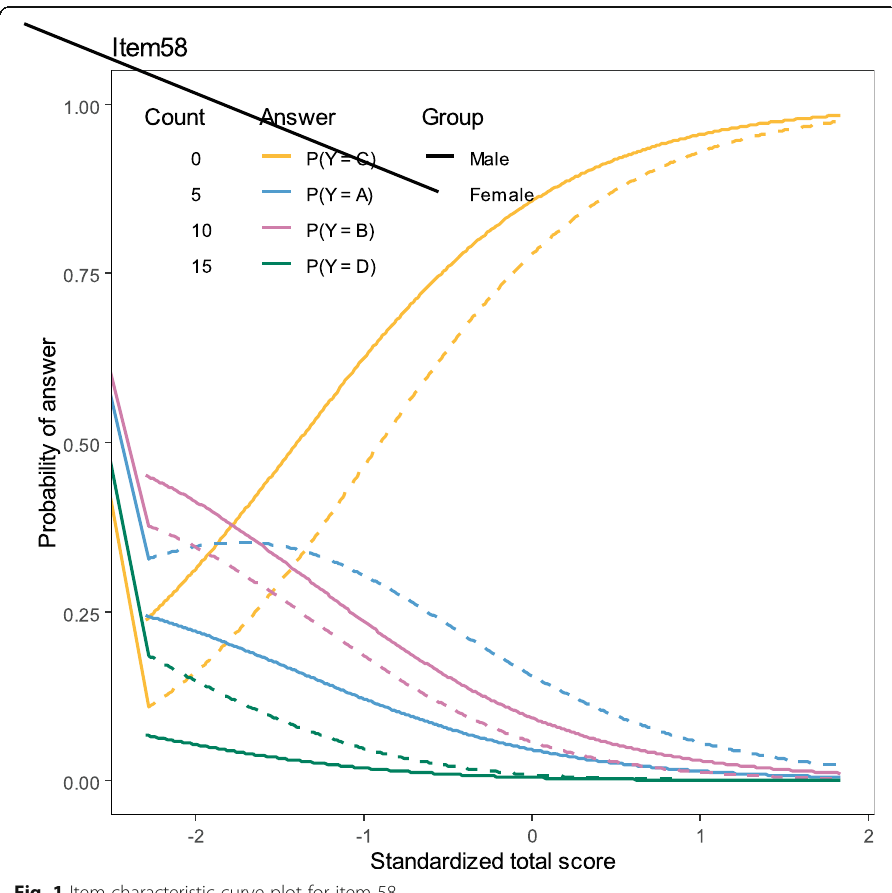
Fig. 1 Item characteristic curve plot for item